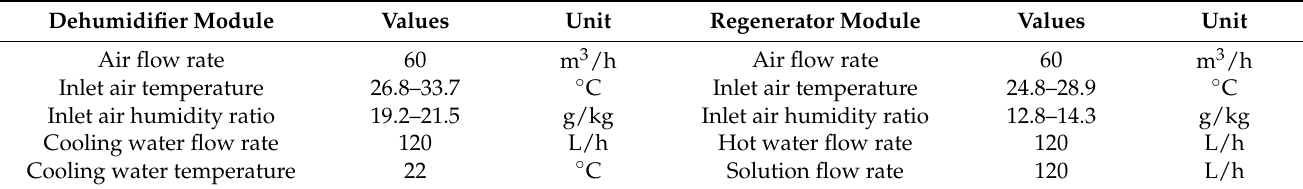
Table 2. Operating conditions of the hollow fiber membrane